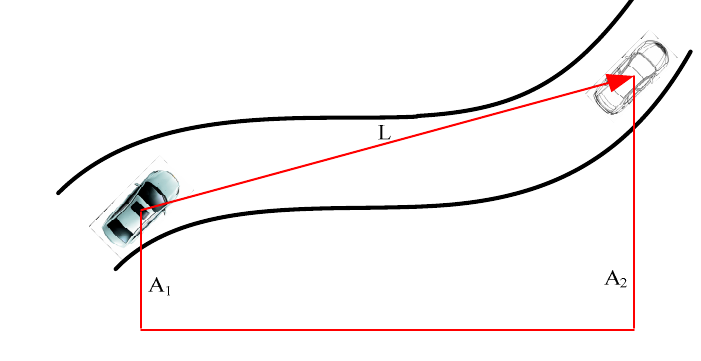
Figure 4. Diagram of road grade calculation.